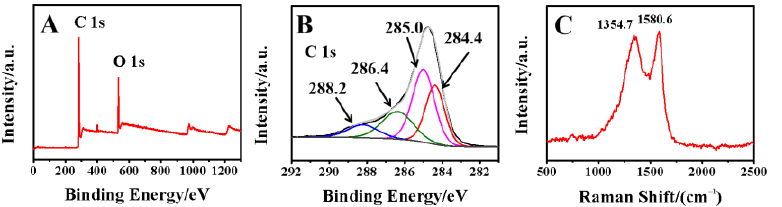
Figure 3. ( A ) XPS survey spectrum and ( B ) high −− resolution C 1s spectrum of GDY, ( C ) Raman spectrum of GDY.